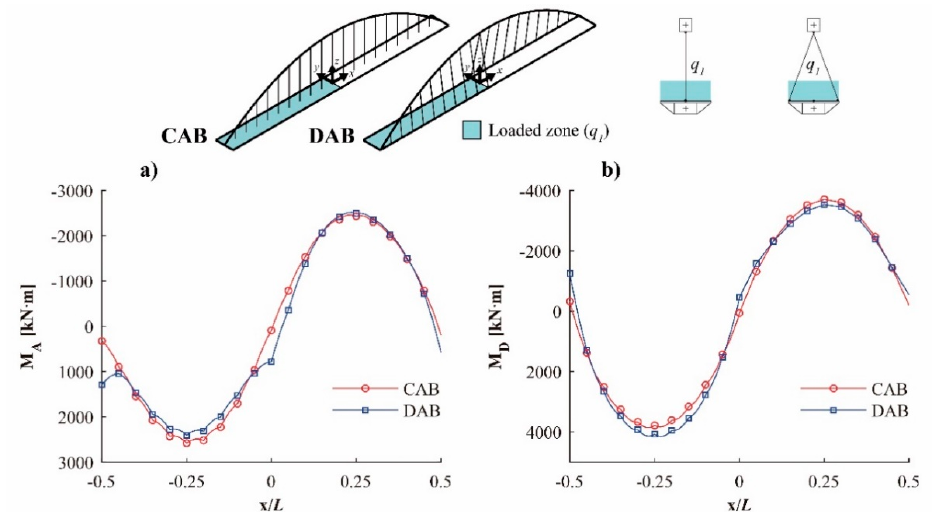
Figure 30. In-plane bending moments under q 1 load, for the arch ( a ) and the deck ( b ). Since the in-plane bending moments in the arch are very similar in the CAB and DAB, the vertical deflections are also similar (Figure 31a). However, the vertical deflections are larger in the DAB deck (Figure 31b), since each cross-section of the deck of the studied DAB is supported by only one hanger anchored at one of its edges.